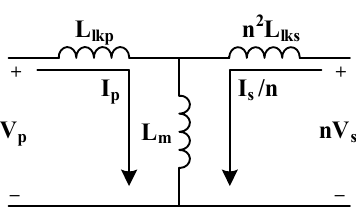
Figure 7. T model of the transformer.